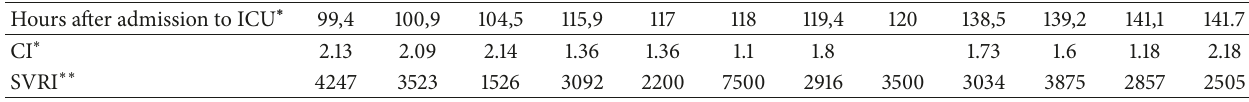
Table 1: Hemodynamic parameters.